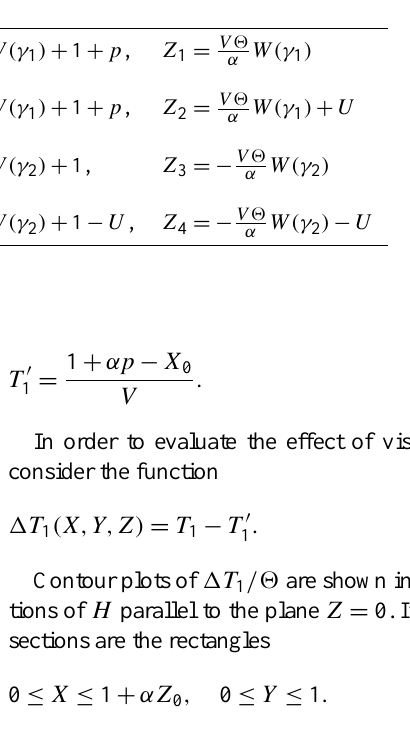
Table 1. Coordinates of the first singular points of an orbit with Z 0 < 0.